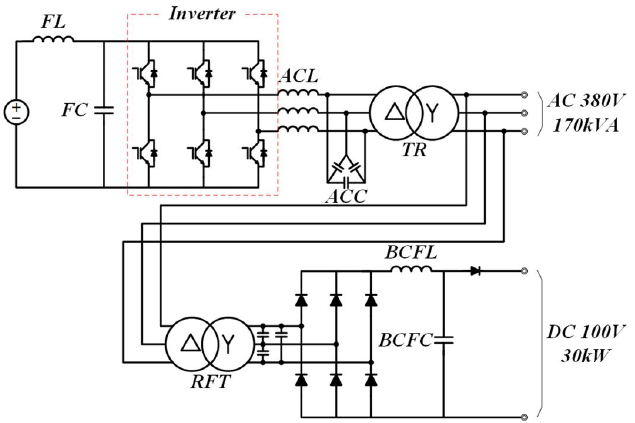
Figure 1. Conventional auxiliary power supply for railway